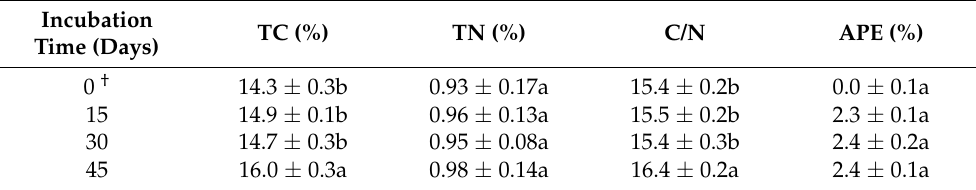
† indicates glucose and (NH 4 ) 2 SO 4 have been added at this time. Different letters indicate the significant difference ( p < 0.05) among different incubation